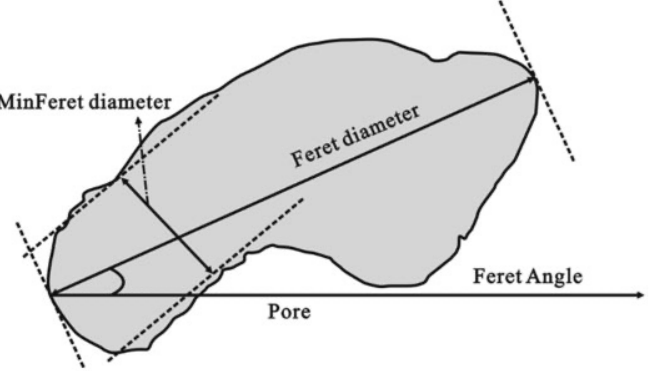
Figure 2. Illustration of the pore space parameters (Feret angle, Feret diameter, and MinFeret Figure2. Illustration of the pore space parameters ( feret angle, feret diameter, and minferet diameter)[48]. diameter)